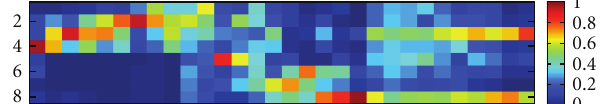
Figure 2: Prototype plot of the filtered and combined data in MarVis-Cluster using 30 prototypes for clustering. Every column represents the average intensity profile (prototype) of associated marker candidates. The prototypes are ordered according to sim- ilarity based on a one-dimensional self-organizing map. The first prototypes represent marker candidates in a WT-specific wound time course (high intensities in the first four conditions and almost no intensities in the last four